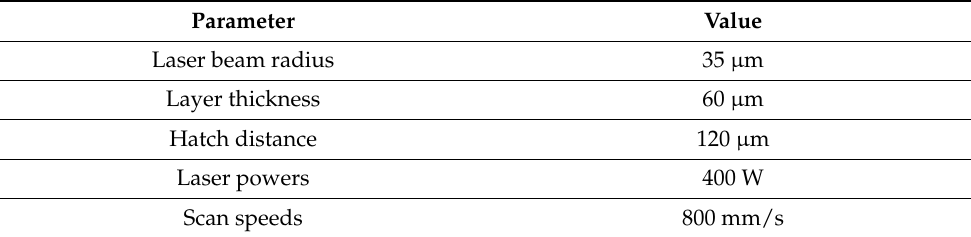
Table 1. SLM process parameters.